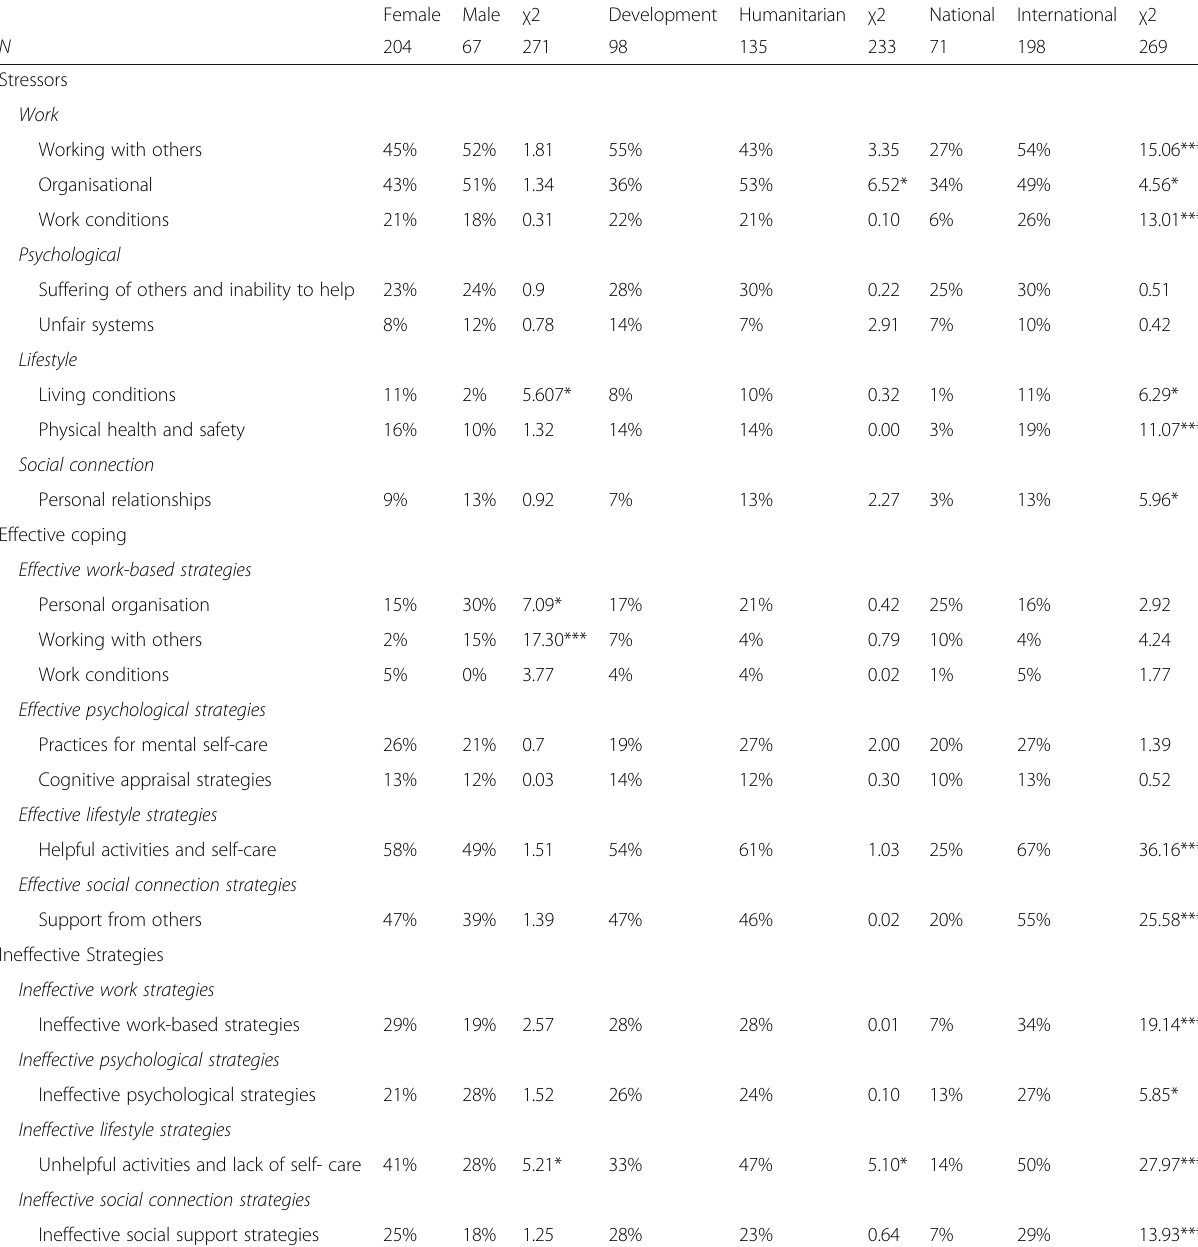
Table 4 Sub-theme by demographic sub-groups, as a percentage of the number of respondents within the sub-group and chi- square